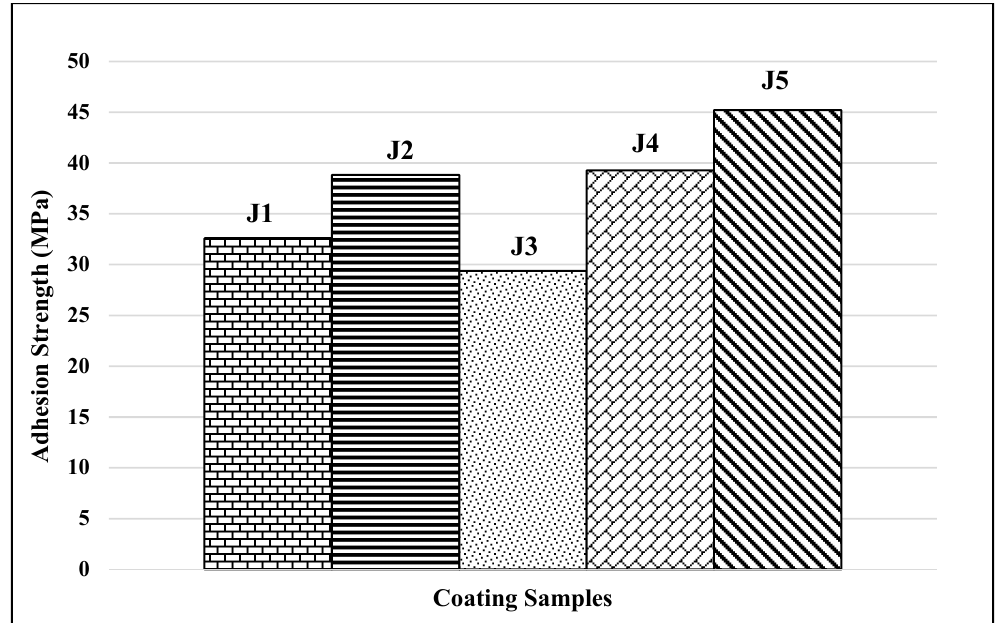
Figure 8. Adhesion strength of the coating samples.